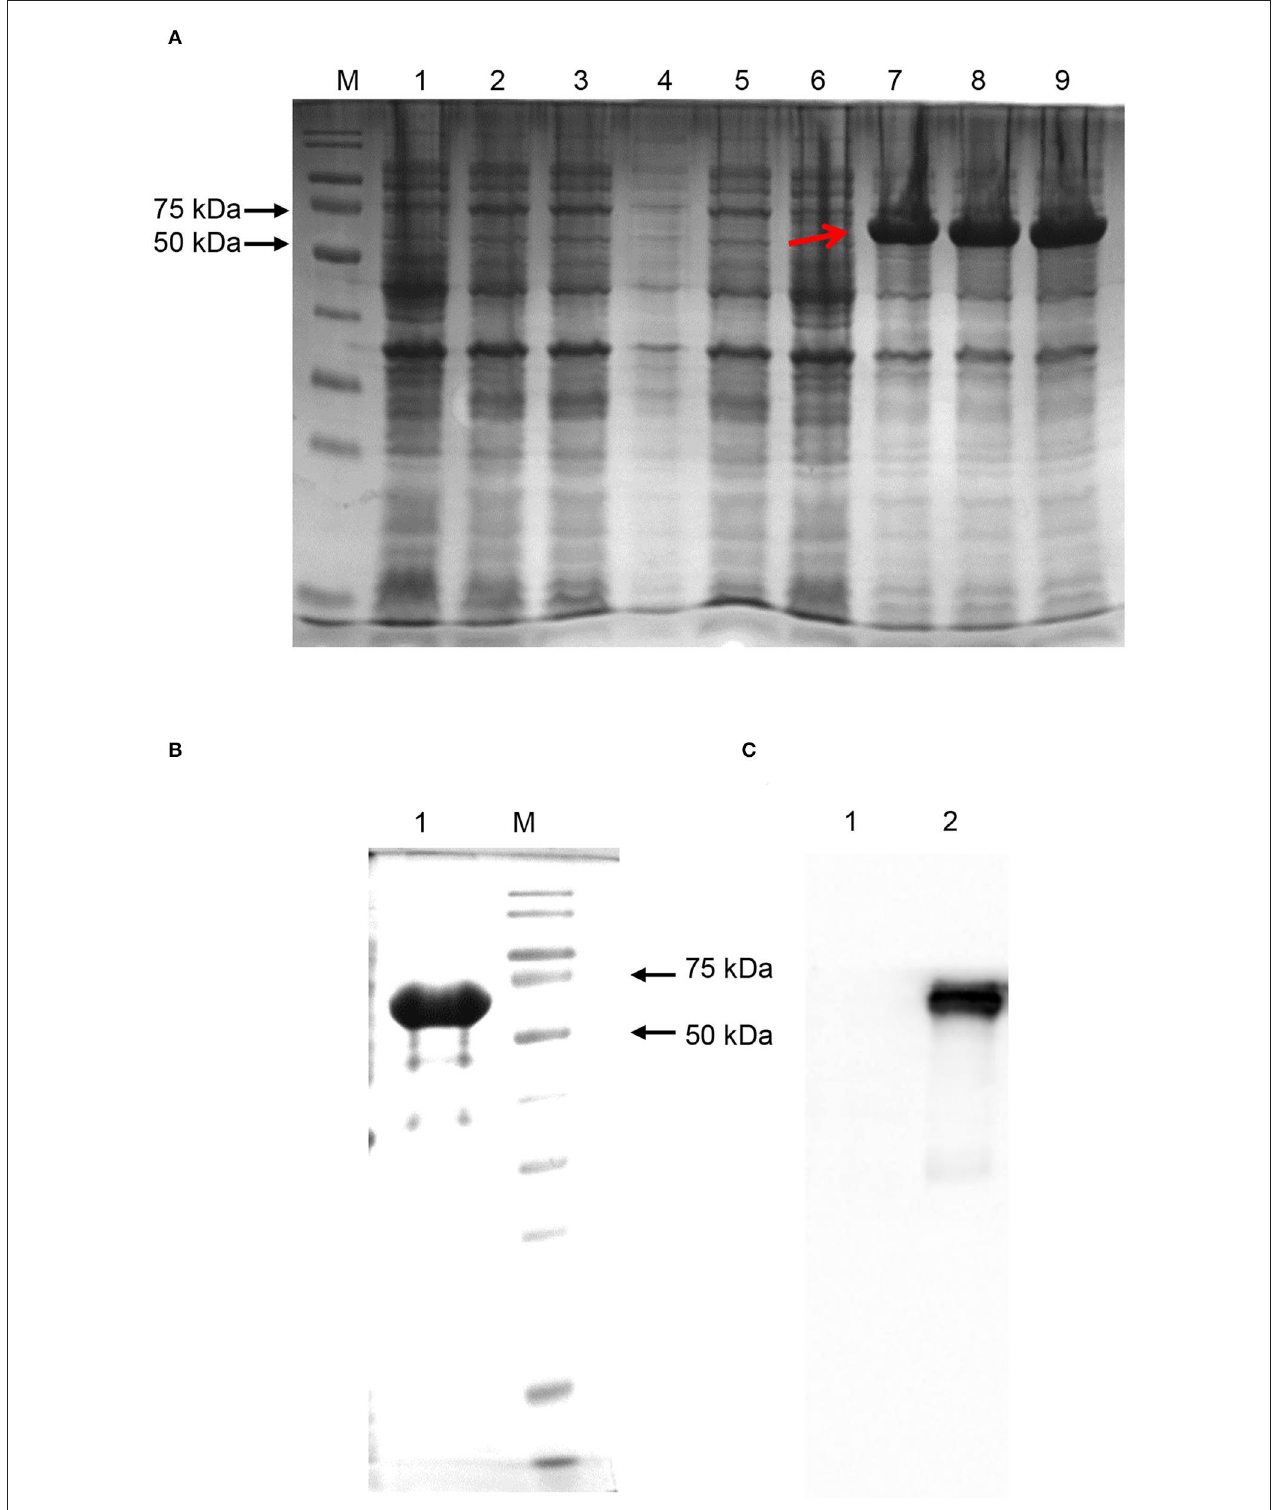
FIGURE 7 | SARS-CoV-2-N expression and purification. (A) SARS-CoV-2-N expression. Proteins in Lanes 1, 2, and 3 were induced under the condition of IPTG concentration of 0.1mM. Proteins in Lanes 4, 5, and 6 were induced under an IPTG concentration of 0.5mM. Proteins in Lanes 7, 8, and 9 were induced under an IPTG concentration of 1mM. The induction temperature of all the lanes was 20 ◦ C and the induction time was 16h. The protein indicated by the red arrow had the best expression. (B) SARS-CoV-2-N purification. The protein was purified by Ni-NTA chromatography and eluted by Elution Buffer. (C) Western blotting by anti-SARS-CoV-2N protein mice monoclonal antibodies (Sinobiological, Beijing).